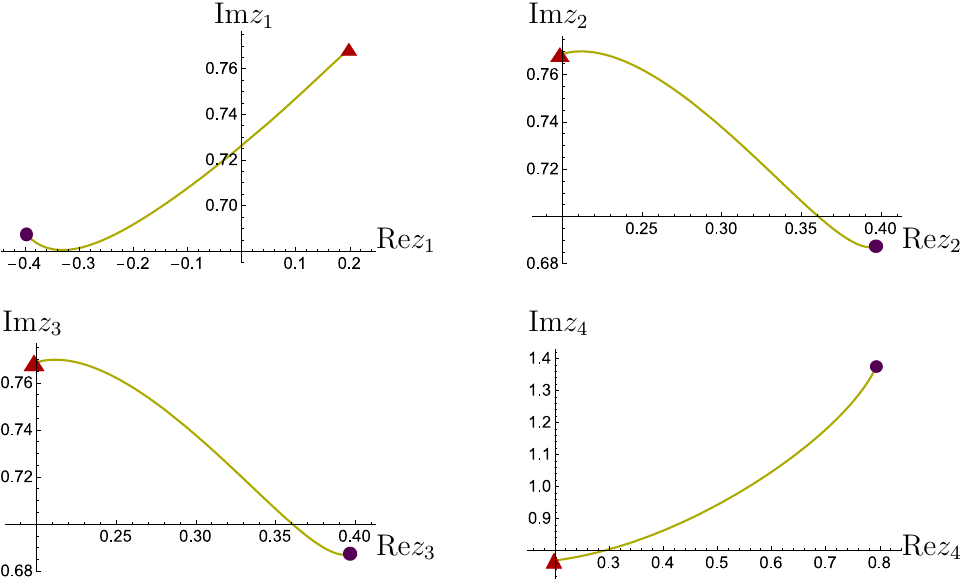
Figure 4 . Numerically integrated bounding domain-wall with z 2 = z 3 that interpolates between AdS 4 solutions with = 1, G 2 symmetry in the UV (red triangle) and N in the IR (purple circle). This domain-wall holographically describes an RG (cid:13)ow between three- dimensional SCFTs with = 1 = 3 supersymmetry N ! N